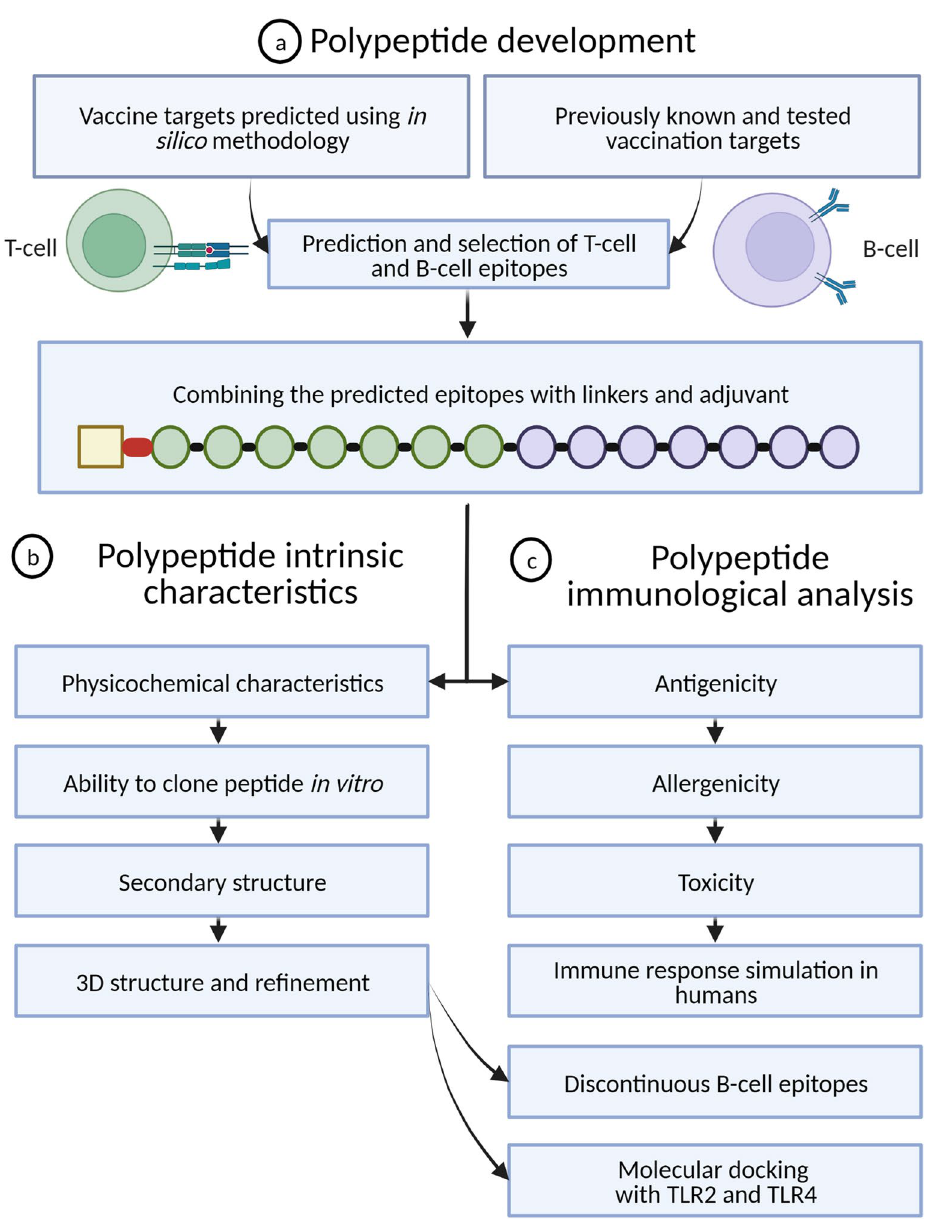
Figure 1. Summary workflow of the approach used to design and analyse the multi-epitope polypeptide. ( a ) Polypeptide development steps, including selection of vaccine targets and respective T-cell and B-cell epitopes. ( b ) Steps of the polypeptide intrinsic characteristics analysis. ( c ) Components of the immunological